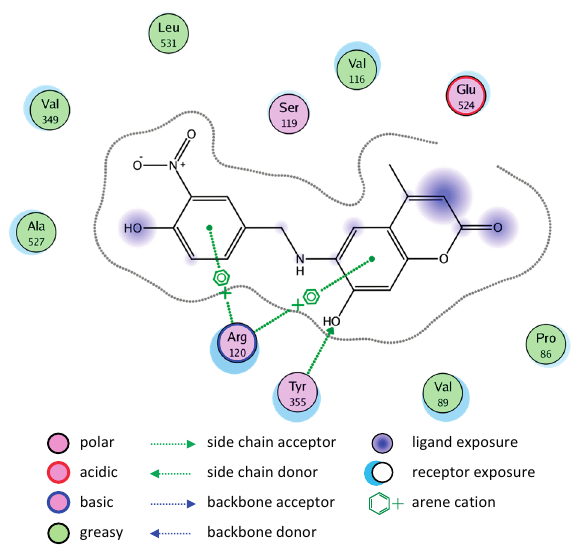
Figure 6. 2D representation of docking of compound 10 into the COX-2 active site.